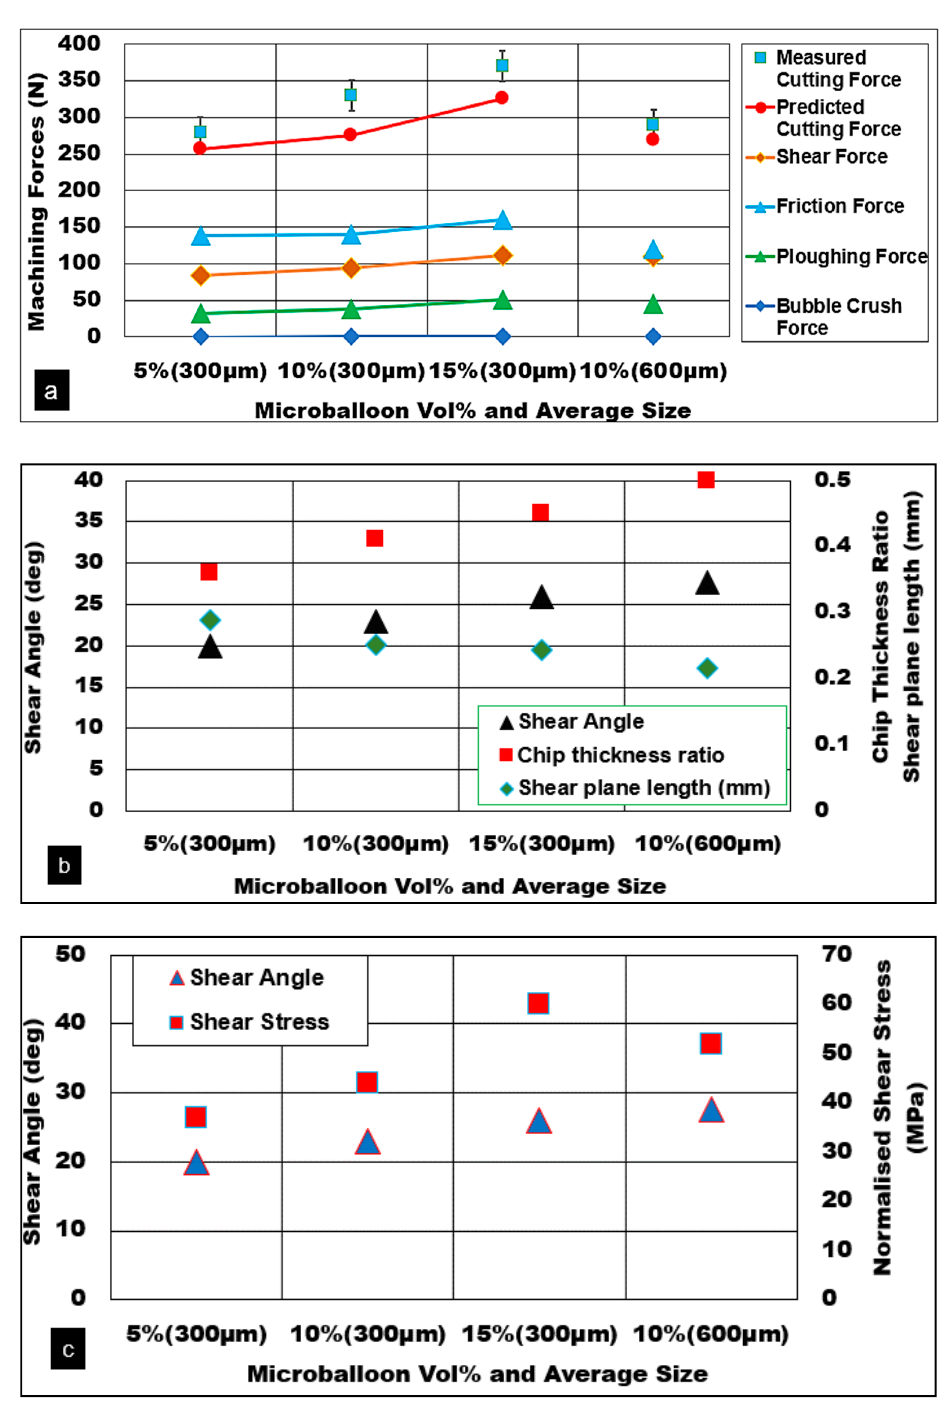
Figure 7. Cutting force predictions: effect of hollow bubble volume fraction and size AZ31 Mg/hollow alumina bubble syntactic foam, (h = 0.1 mm, Vc = 50 m/min, b = 3 mm). ( a ) Measured and predicted cutting forces ( b ) volume fraction vs shear angle ( c ) volume fraction vs normalized shear stress